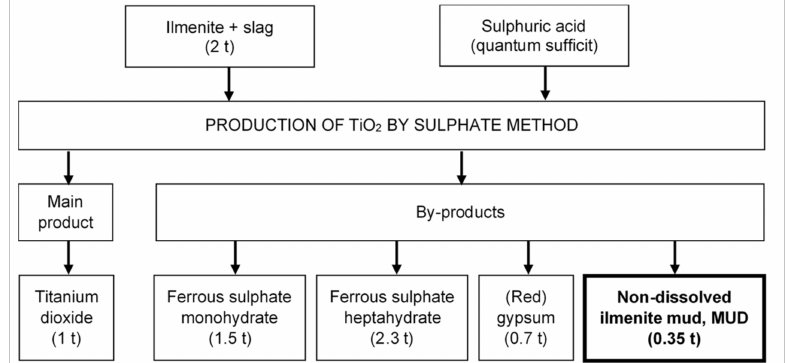
Figure 1. By-products generated per ton of the final product during the production of TiO 2 using the sulphate method (data calculated according to a Spanish factory in Huelva